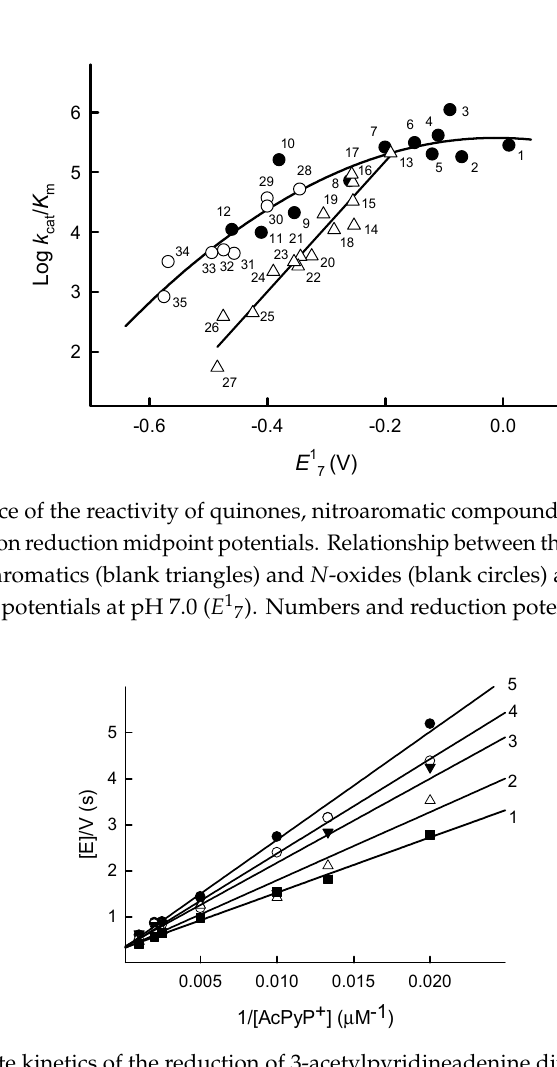
Figure 4. Effects of the ionic strength on the reactivity of PfFNR towards the electron acceptors. The dependence of log k cat / K m for ferricyanide (1), Fe(EDTA) - (2), benzylviologen (3) and tetramethyl-1,4- benzoquinone (4) on the ionic strength of the phosphate buffer at pH 7.0 is shown . 2.2. Kinetics of PfFNR Oxidation under Multiple Turnover Conditions In order to get insight into the enzyme reoxidation mechanism, we investigated the spectral changes of Pf FNR-bound FAD during its multiple turnover under aerobic conditions in the presence of NADPH and tetramethyl-1,4-benzoquinone. This electron acceptor does not absorb light at ≥ 460 nm, and its semiquinone form is rapidly reoxidized by oxygen [26]. In control experiments performed in the absence of quinone, the initial fast phase of FAD reduction by NADPH monitored at 460 nm is followed by its slower reoxidation by oxygen (Figure 5A). Importantly, this is accompanied by a transient increase in absorbance at 600 nm at the same time scale (Figure 5A). The addition of quinone accelerates the reoxidation of FADH - and the decay of the 600-nm absorbing